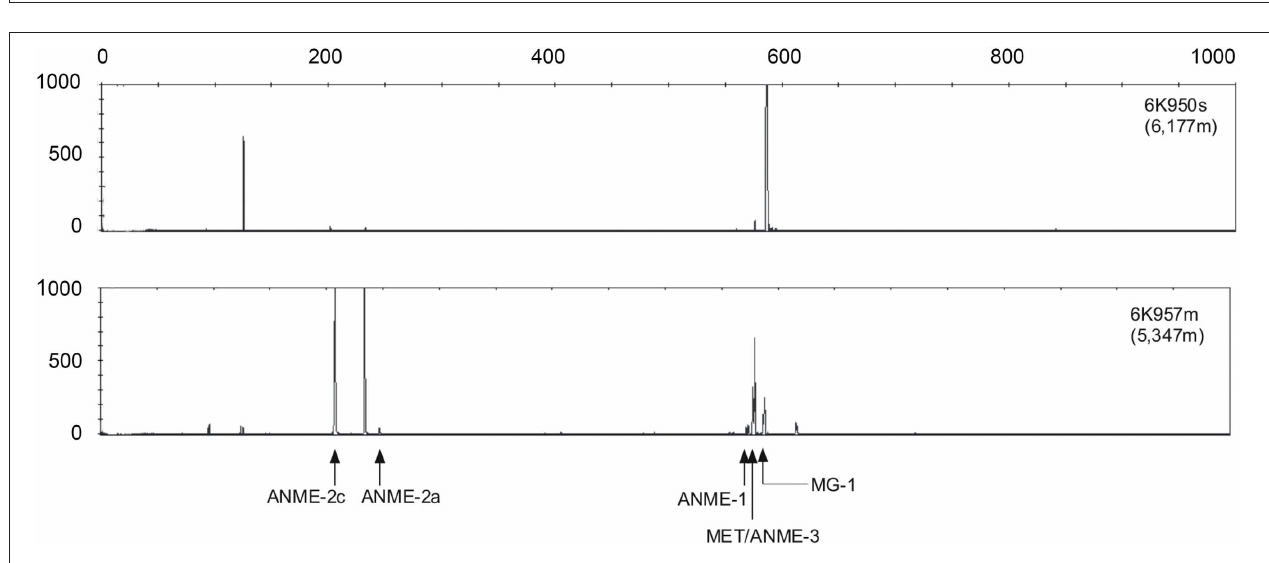
sulfide oxidizing and sulfate reducing bacterial groups. The lengths of the fragments are displayed on the x-axis and relative fluorescence intensity of peaks is shown on the y-axis.